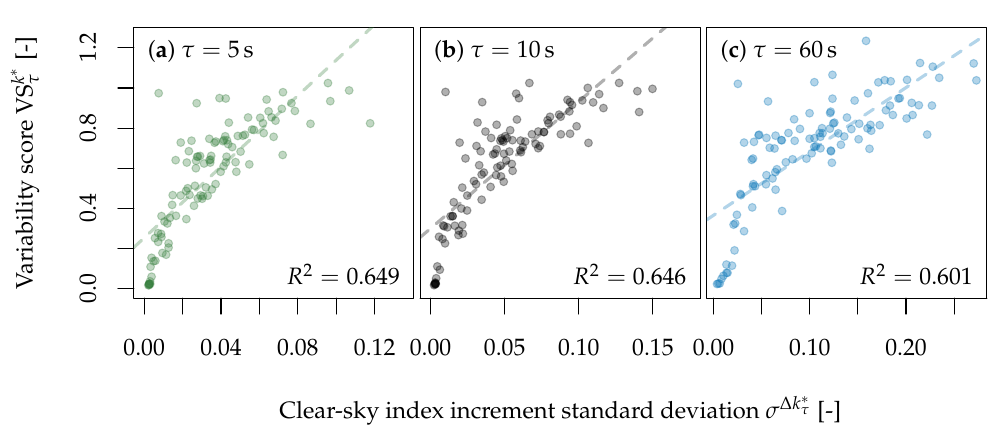
A comparison between daily values of the clear-sky index variability score VS k ∗ τ (cf. Equation (8)) and the clear-sky index increment standard deviation σ ∆ k ∗ τ (cf. Equation (9)) for three time steps ( a ) τ = 5s, ( b ) τ = 10s, and ( c ) τ = 60s, using 105 days worth of single-sensor 1s clear-sky index estimates derived from irradiance data collected during the HOPE campaign [138,139] (i.e., the same data as in Figure 4). Least-square fits are included as dashed lines, and the corresponding coefficients of determination R 2 are quoted in each